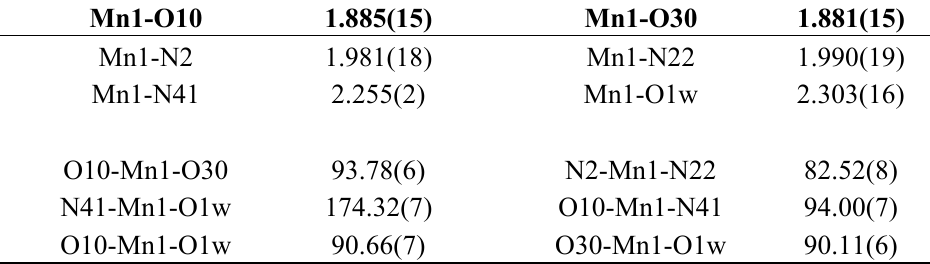
Table 1. Selected bond lengths (Å) and angles (°) for Complex 4